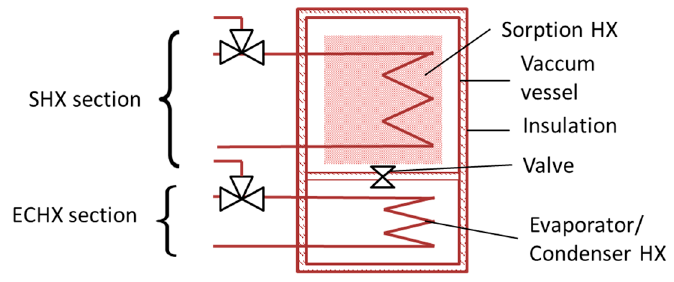
Figure 4. Schematic of the considered storage configuration.